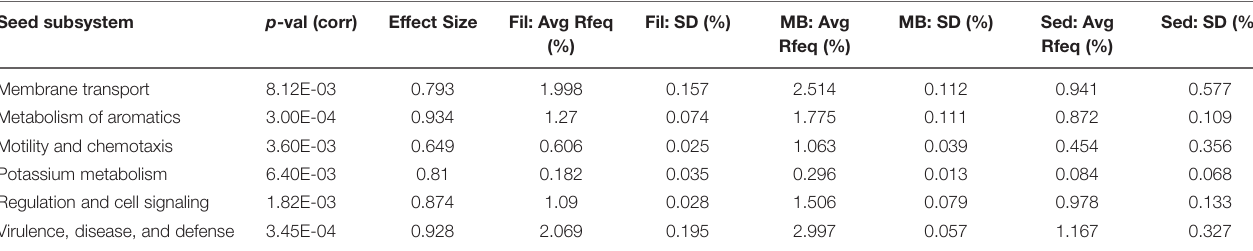
TABLE 3 | Functional annotations (SEED subsystem level I) that are overrepresented in microbialites relative to the surrounding environment by ANOVA using